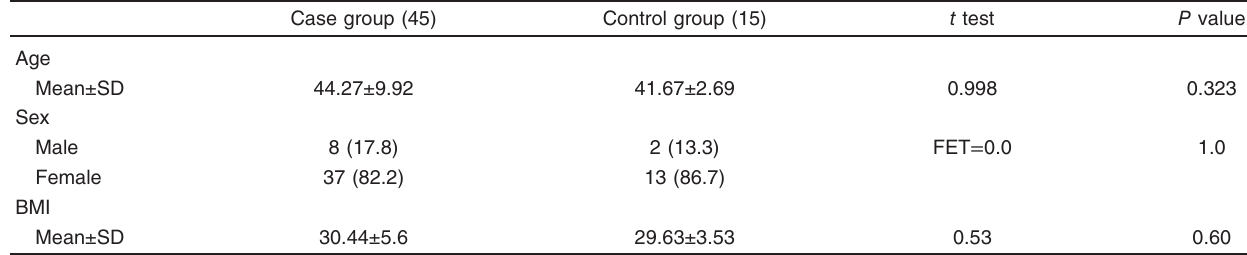
Table 1 Comparison between case and control groups regarding personal data